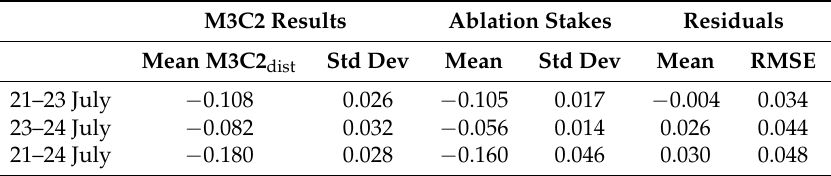
Table 3. Summary of surface change (m) from point cloud differences and in situ measurements at ablation stakes. Residuals are the differences between M3C2 and stake measurements at each stake